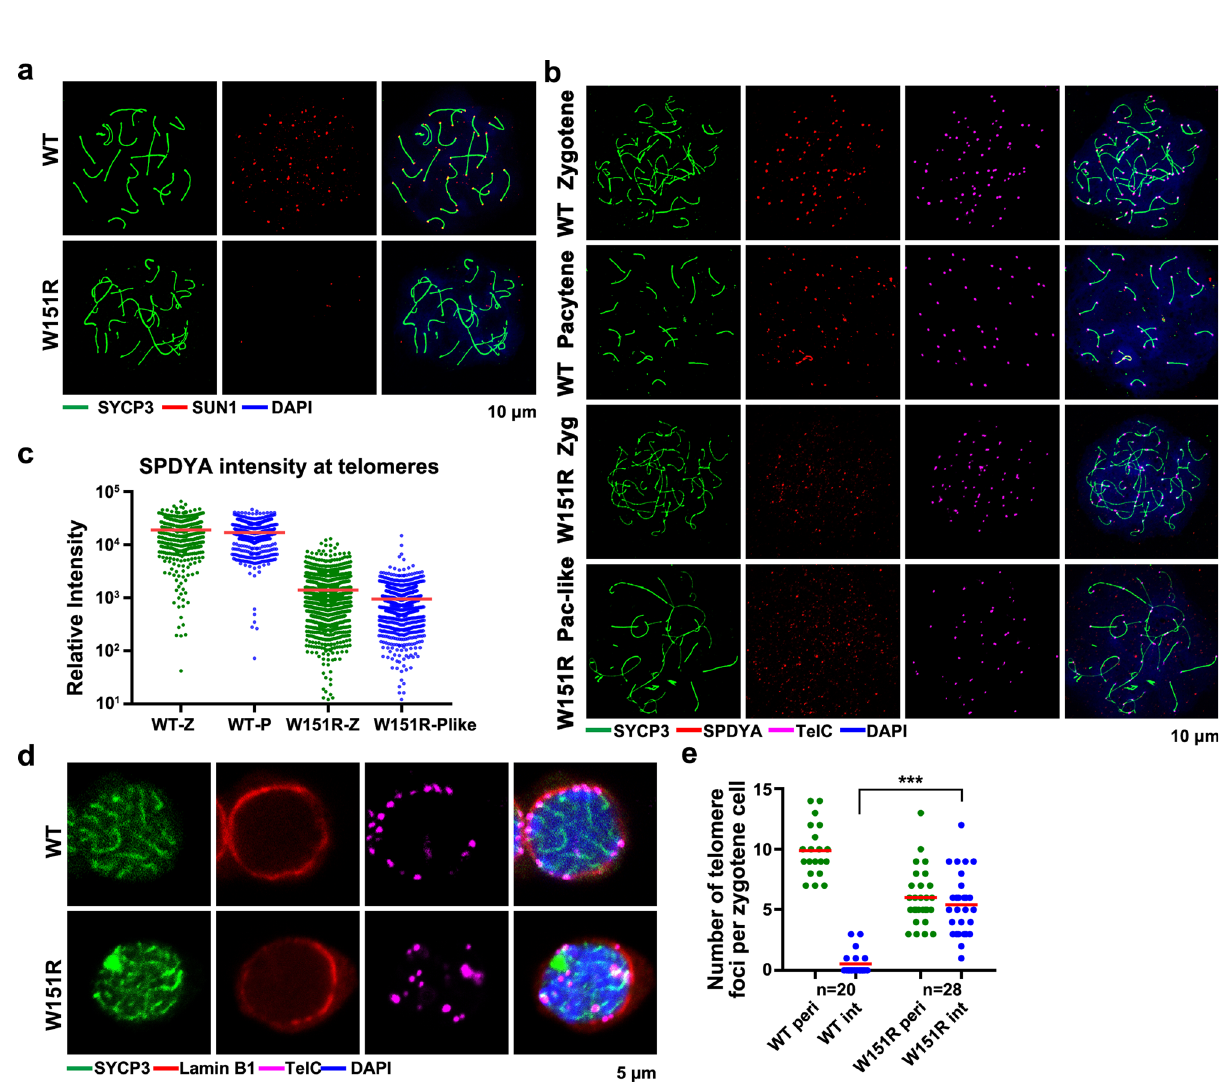
Fig. 4 The SUN1 – SPDYA interaction regulates telomere – LINC complex connection and telomere NE attachment. a IF staining of spermatocyte chromosome spreads for SYCP3 (green) and SUN1 (red). DNA was stained by DAPI (blue). Scale bar, 10 μ m. b IF-FISH staining of spermatocyte chromosome spreads for SYCP3 (green), SPDYA (red), and telomeric DNA (TelC, magenta). (Zyg zygotene, Pac-like pachytene-like). Scale bar, 10 μ m. c Quanti fi cation of the relative intensity of SPDYA foci at telomeres in panel b . A total of n = 8 WT Zygotene spreads (557 telomeres) (WT-Z), n = 12 WT pachytene spreads (498 telomeres) (WT-P), n = 19 W151R zygotene spreads (1269 telomeres) (W151R-Z) and n = 15 W151R pachytene-like spreads (733 telomeres) (W151R-Plike) were analyzed. Red lines indicated the mean values. d Equator images of structurally preserved zygotene spermatocytes stained for SYCP3 (green), Lamin B1 (red), and telomere FISH (TelC, magenta). Scale bar, 5 μ m. e Quanti fi cation of the number of telomere foci at the nuclear periphery (peri) or internal domain (int) as shown in panel d . A total of n = 20 WT and n = 28 W151R spermatocytes were counted. Red lines indicated the mean values. A two-sided Student ’ s t test was performed, *** P = 2.6E-10. Source data are provided as a Source Data fi